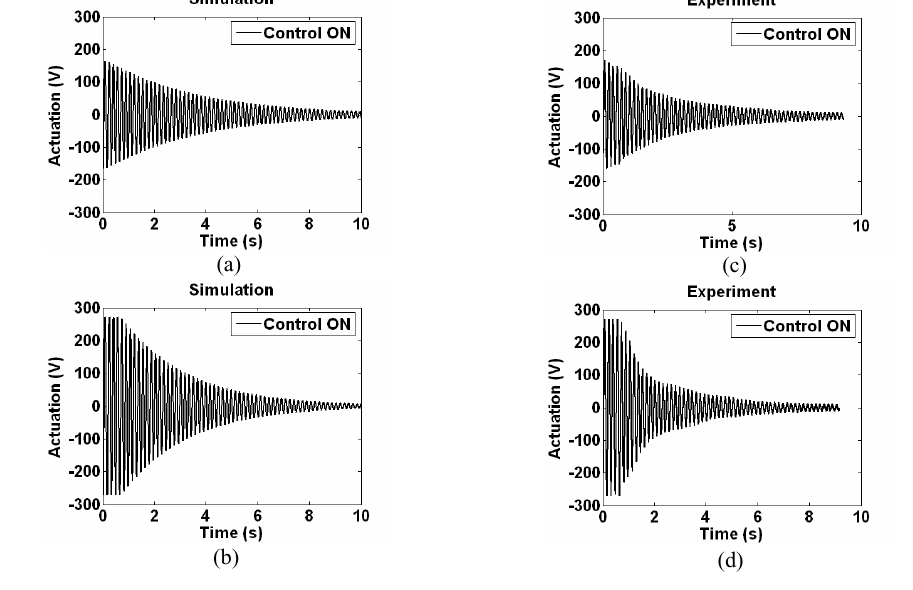
Fig. 9. Case 1 actuation voltages for strain feedback